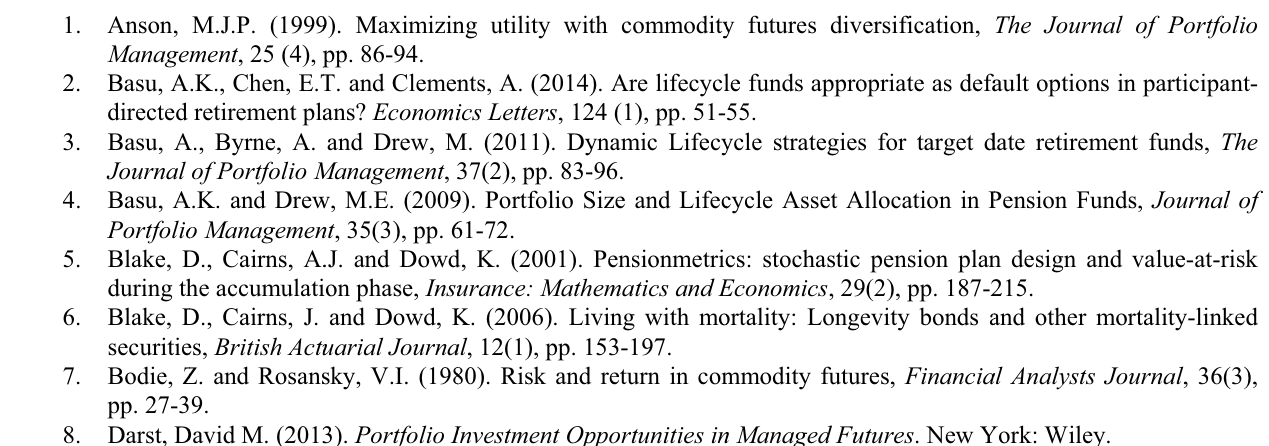
F Fig. 3. Expected d Tail Loss and d Value-at-Ris cted Tail Los ss and Valu ue-at- ifferent inve estment strate egies retirement at 5 year interv vals. pected Tail Loss gene nt horizon. W g investmen irement, vari iation in the ategies, wit th all strate VaR levels in n the first de time, as V VaR reduces between str ategies. Afte etiree VaR is, on aver with allocati on to CTA. r tail risk c compared to tion, althoug n the strategy dities. The tives howeve , having the h d Tail Loss on strategy in erformed by ter 12 year strategy and